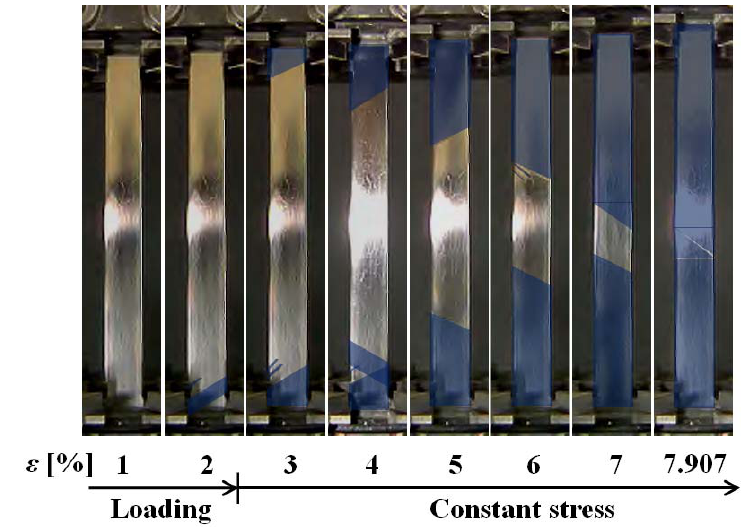
Figure 8. Photographs of specimen surface at various strains ε under stress rate of d σ /d t = 0.5 MPa/s up to a strain ε of 2% followed by constant